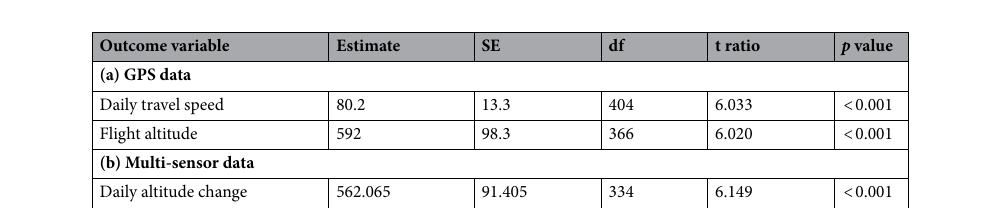
Table 2. Results of post-hoc Tukey’s comparisons between barrier and hospitable biome categories based on binomial GLMMs where the effect of biome category was tested on (a) travel speed and flight altitude based on GPS observation (n = 408; 19 individuals) and (b) daily altitude change based on multi-sensor logger data (n = 338 days; 5 individuals). Positive estimates refer to a positive effect of the barrier biome category.